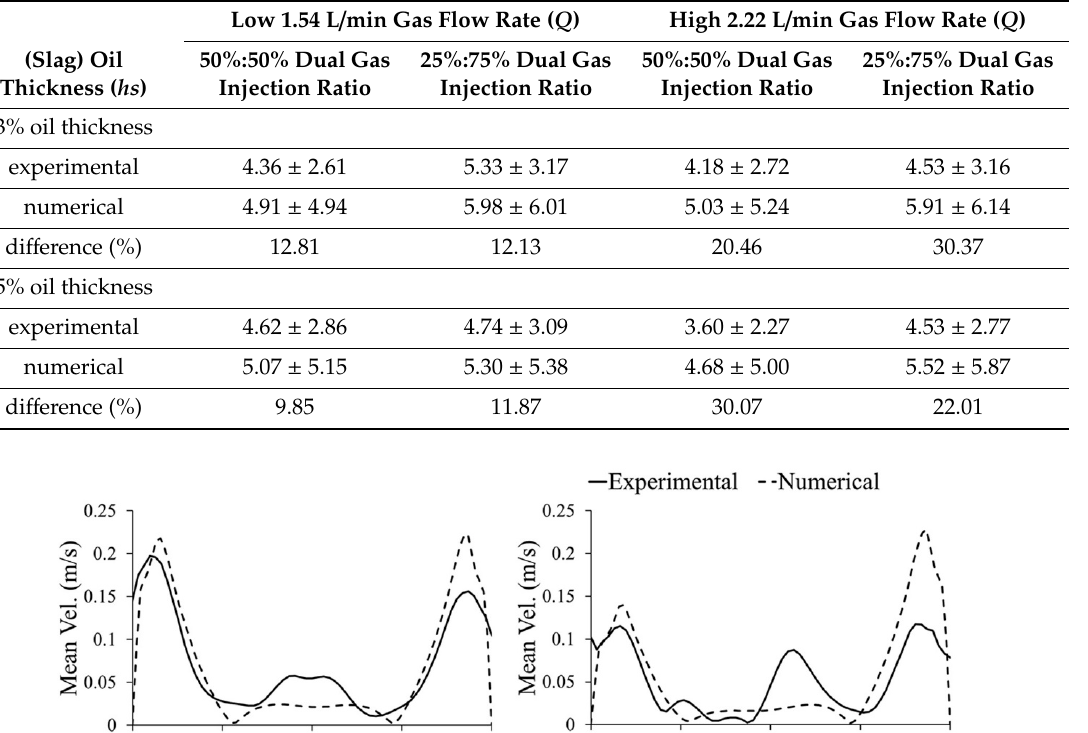
Table 3. Mean values of velocity v ( × 10 − 2 m / s) for the experimental and numerical model along the longitudinal plane (symmetry plane) for the eight cases presented in this study.